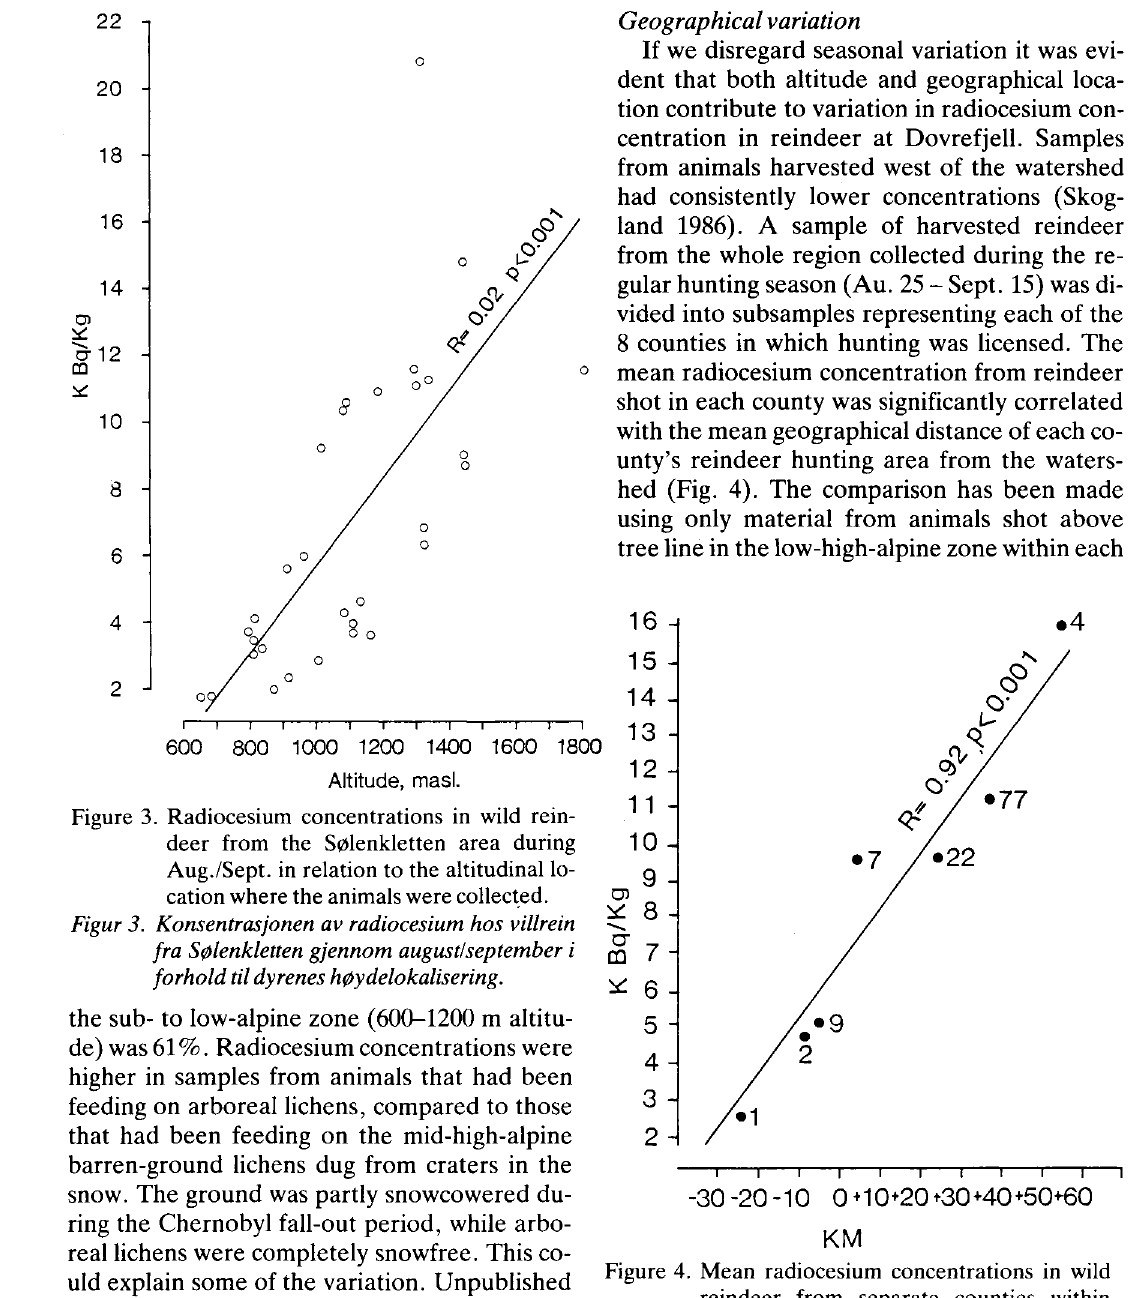
Figure 4. Mean radiocesium concentrations in wild reindeer from separate counties within wild reindeer management units located along a west-east gradient across the wa tershed at Dovrefjell. Aerial distance is measured in km from the watershed. Figur 4. Gjennomsnittlig konsentrasjon av radiocesi um f ra forskjellige kommuner innen villrein- områder beliggende langs en vest-øst gradi ent over vannskillet på Dovrefjell. Distanse i luftlinje fra vannskillet er angitt i